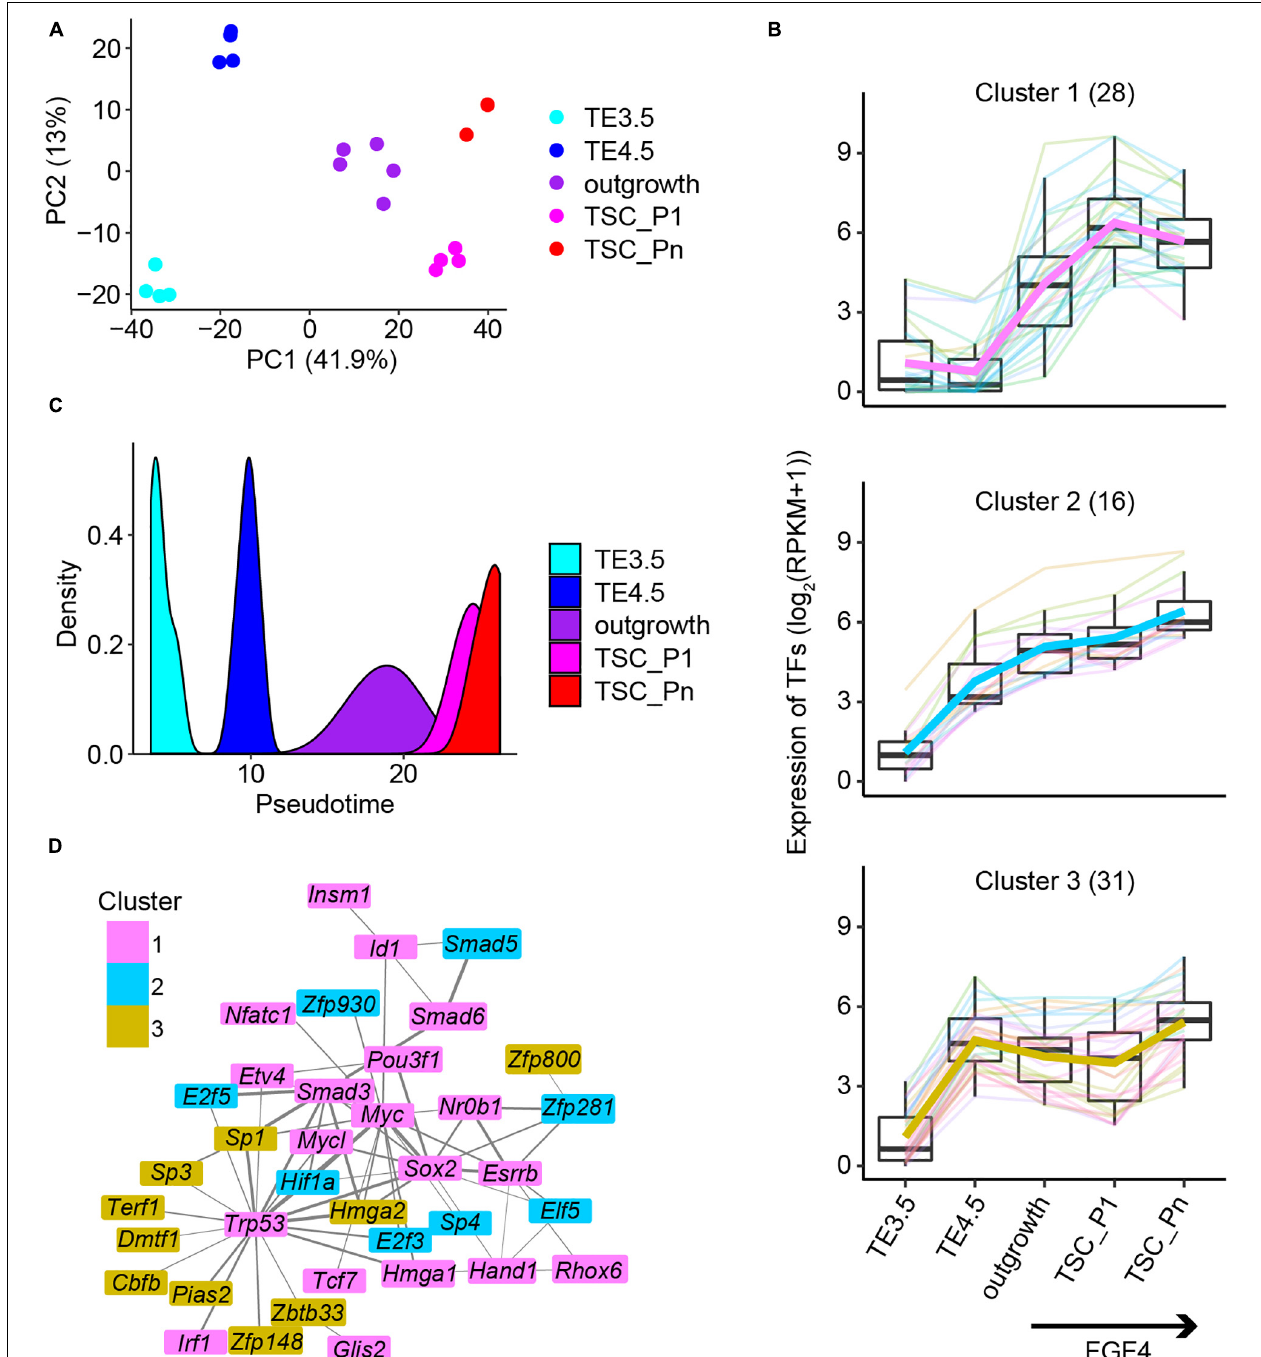
FIGURE 2 | The key transcription factors critical to the derivation of NF TSCs. (A) Principal component analysis (PCA) of the transcriptomic data of NF samples. (B) Expression patterns of the 75 transcription factors in Clusters 1–3 ( Supplementary Figure 2B ). (C) The pseudotime of NF TSC derivation inferred from the transcriptomes of the 75 transcription factors (TFs) in (B) . (D) Protein–protein interaction (PPI) networks of the 75 TFs in (B) . The thickness of the lines represents the PPI scores, and the color represents the gene cluster in Supplementary Figure 2B .